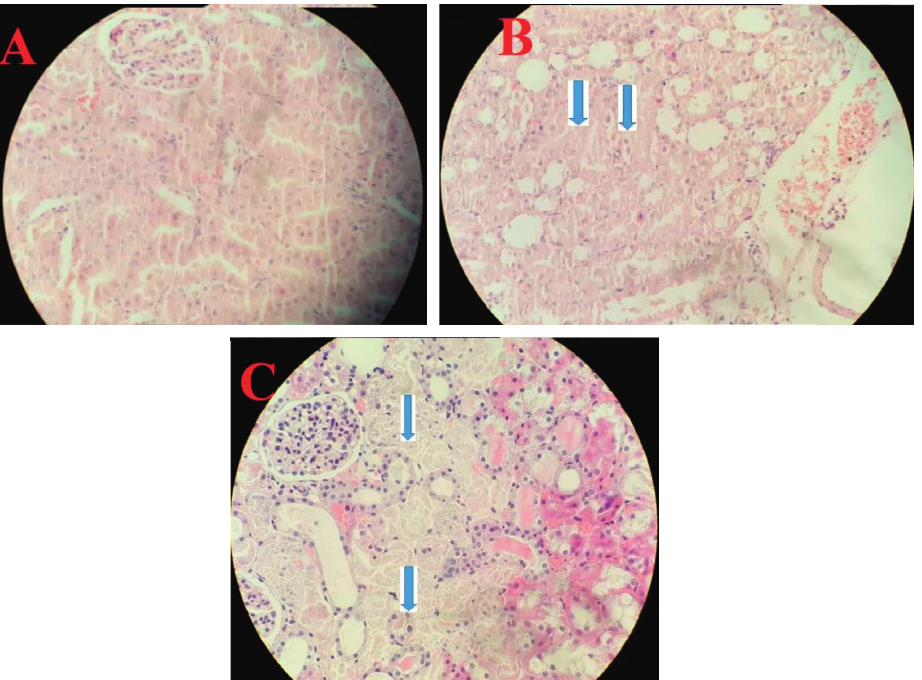
Figure 5: Histopathological findings of kidney tissue stained with hematoxylin and eosin (10x): (a) sham control, (b) I/R, and (c) I/ R + SP ; SP : Stachys pilifera ; I/R: ischemia-reperfusion; blue arrow � tubular